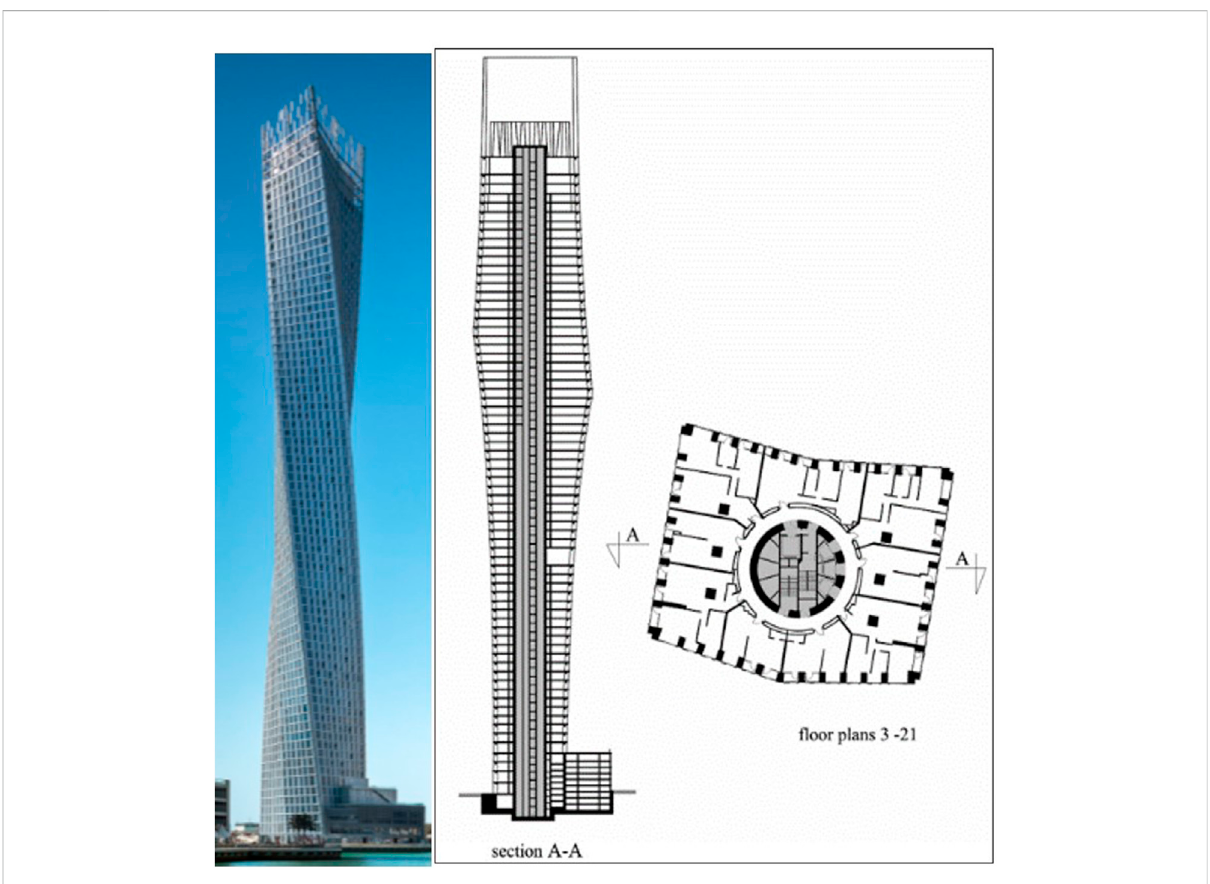
FIGURE 3 Cayan tower dubai (Alkhatib et al.,